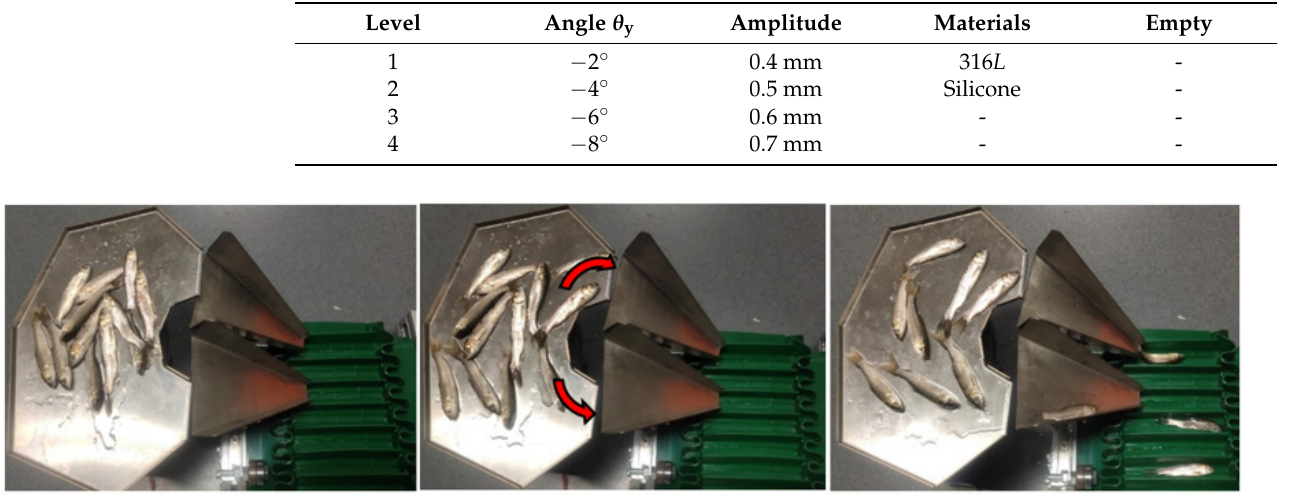
Figure 9. The process of head and tail orientation of fry.